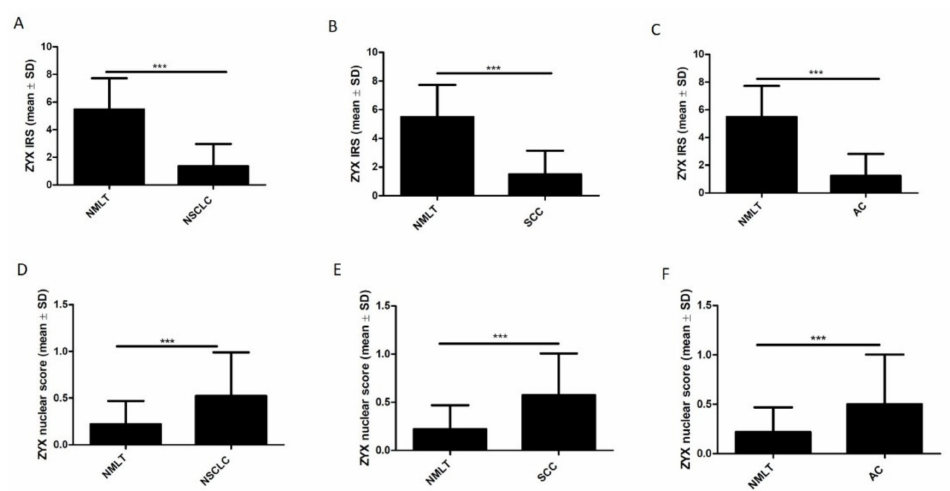
Figure 5. Immunohistochemical (IHC) analysis of ZYX expression in NSCLC cells and in NMLT cells. The graphs showing the intensity of cytoplasmic (IRS) and nuclear (nuclear score) expression of ZYX for the whole NSCLC group ( A , D , respectively), levels of cytoplasmic and nuclear ZYX in lung SCCs ( B , E , respectively), levels of cytoplasmic and nuclear ZYX in lung ACs ( C , F , respectively) compared with NMLT. Mann–Whitney test (*** p < 0.001).